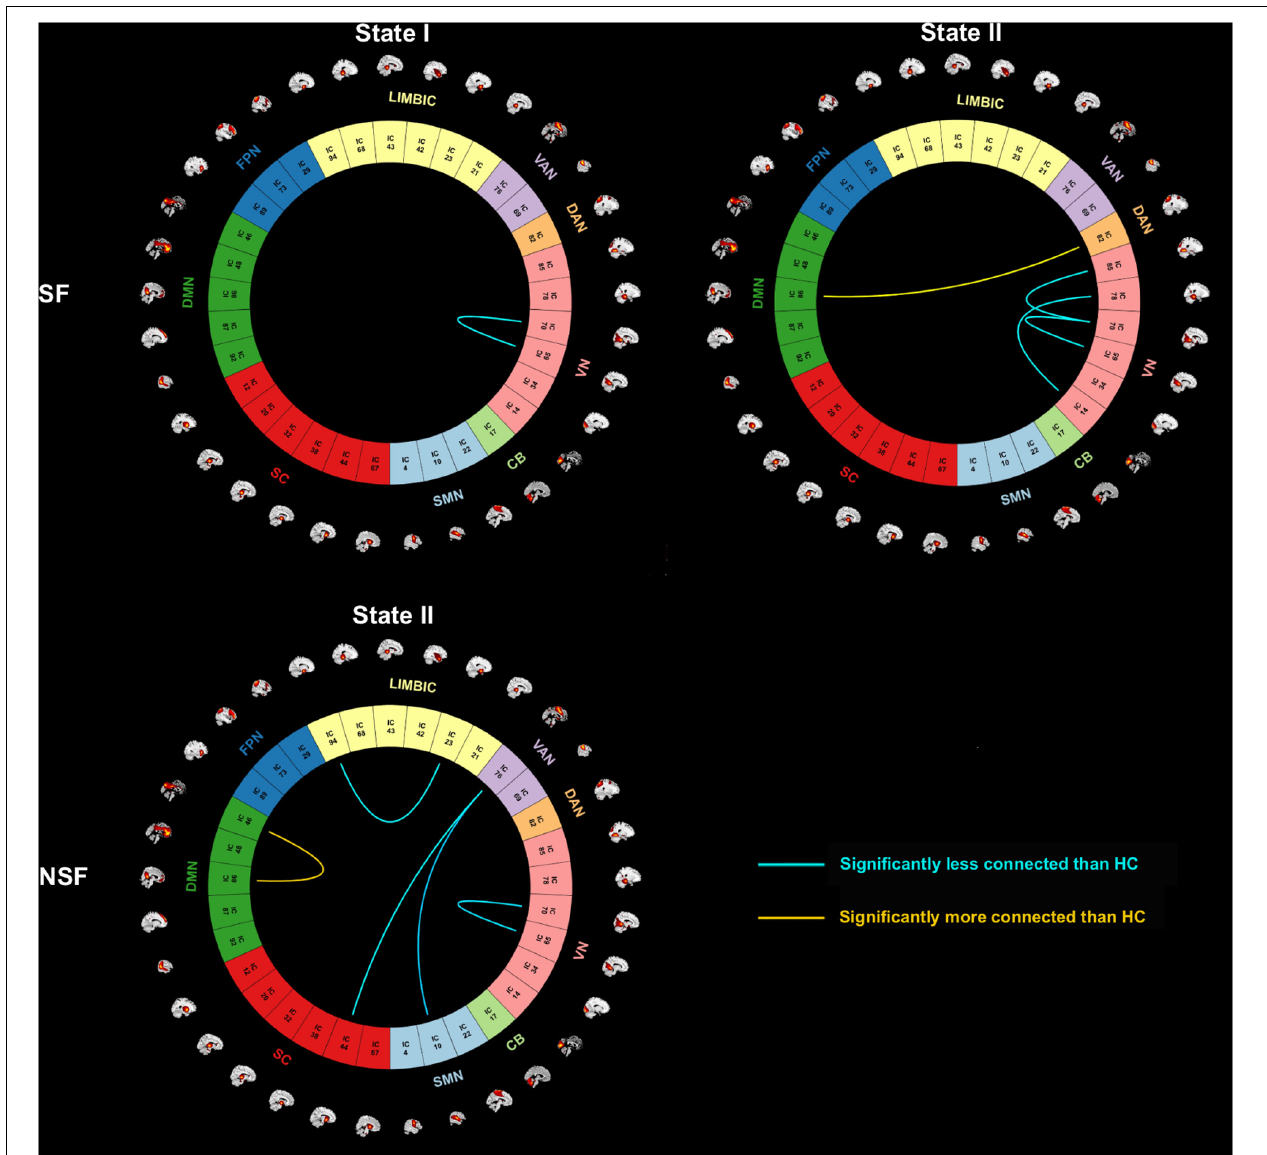
FIGURE 3 | Dynamic functional connectivity state results. Subgroup-specific circle plots of significant dynamic functional connectivity differences in each state, where SF and NSF patients had a weaker or stronger connectivity pattern in comparison to the HC. (post hoc t-tests, P < 0.05, FDR-corrected for multiple comparisons). CB, cerebellum; DAN, dorsal attention network; DMN, default mode network; FPN, frontoparietal network; HC, healthy controls; LIM, limbic; NSF, not seizure-free; SC, subcutaneous; SF, seizure-free; SMN, sensorimotor network; VAN, ventral attention network; VN, visual